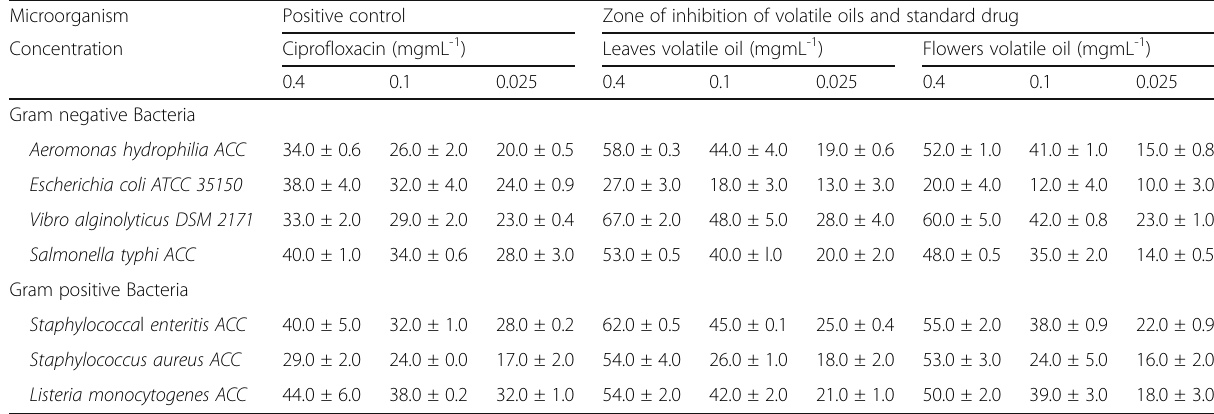
Table 3 Inhibition zone (mm) showing antibacterial activities of volatile oils and ciprofloxacin against bacterial test organisms Microorganism Positive